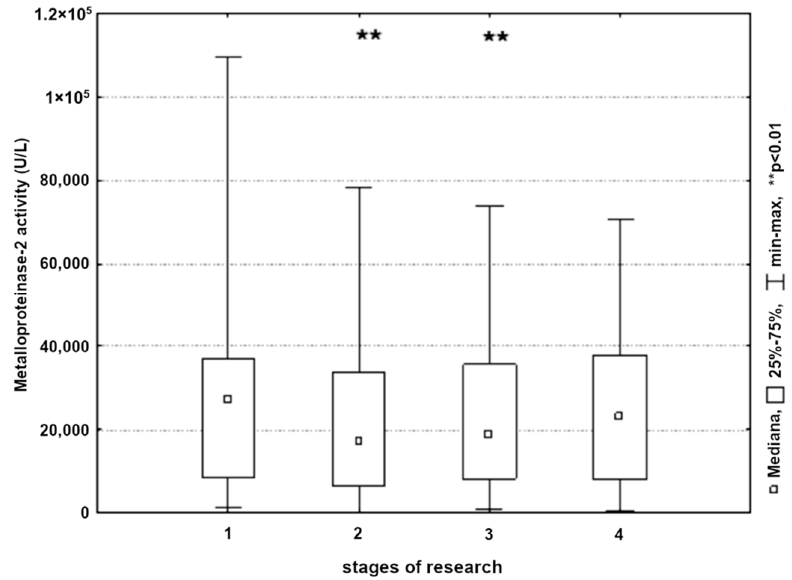
Figure 2. Metalloproteinase-2 activity in patients in the next stages of research (1, 24 h before surgery; 2, 8 h post-surgery; 3, 24 h post-surgery; and 4, 48 h post-surgery). A significant increase in MMP-9 activity in the blood was found in the endarterectomy group and applied to all studied patients. As with the MMP-2 analysis, the largest changes were observed immediately post-surgery ( p < 0.001) and on the first postoperative day ( p < 0.01) (Figure 3).